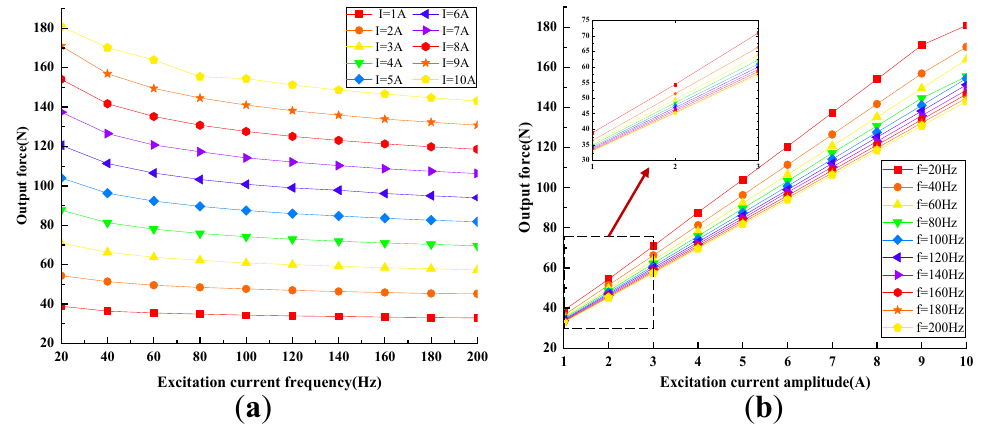
Figure 5. The variation curve of the electromagnetic force with the current: ( a ) the variation of current frequency; ( b ) current amplitude variation It can be seen from Figure 5 that the electromagnetic force generated by the electro ‐ magnetic actuator has a positive linear correlation with the magnitude of the current am ‐ plitude. With the increase of frequency, the electromagnetic force decreases gradually. In addition, the electromagnetic force of the actuator under different excitation cur ‐ rent amplitude and frequency was tested by indirect measurement method, as shown in Figure 6. When the frequency is constant, the electromagnetic force increases approxi ‐ mately linearly with the increase of the current; when the current amplitude is constant, the electromagnetic force decreases with the increase of the frequency, and the decay rate gradually decreases. The test results are basically consistent with the simulation results.